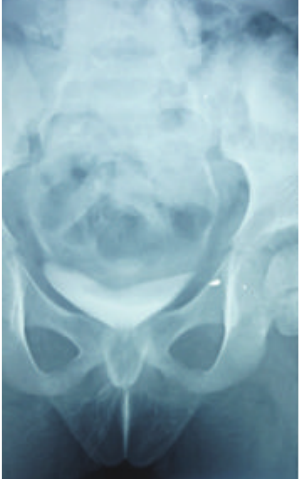
Figure 3: Urinary leakage.